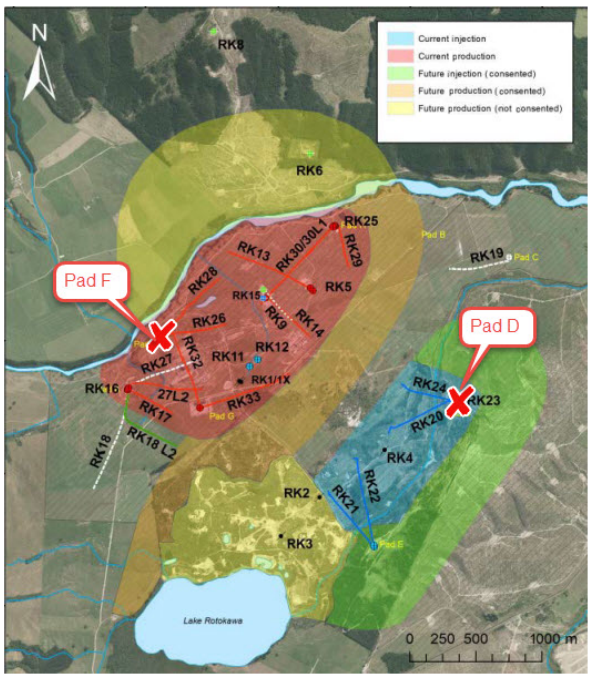
Figure 1. System management plan overview showing wells in pro- duction area (red) and injection area (blue); Pad F and D are marked well top areas that are used for reference in the result